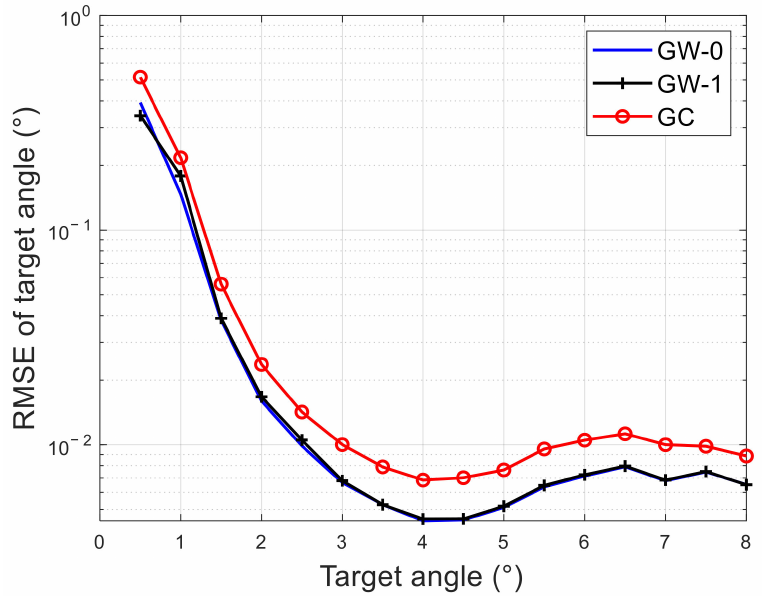
Figure 7. The RMSEs of the target angle for the BSC algorithm under different noise types against the